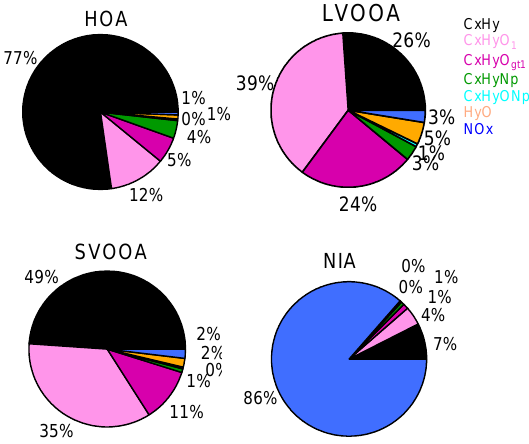
Figure 6. Mass fractional compositions of ion families for the determined PMF factors. 20